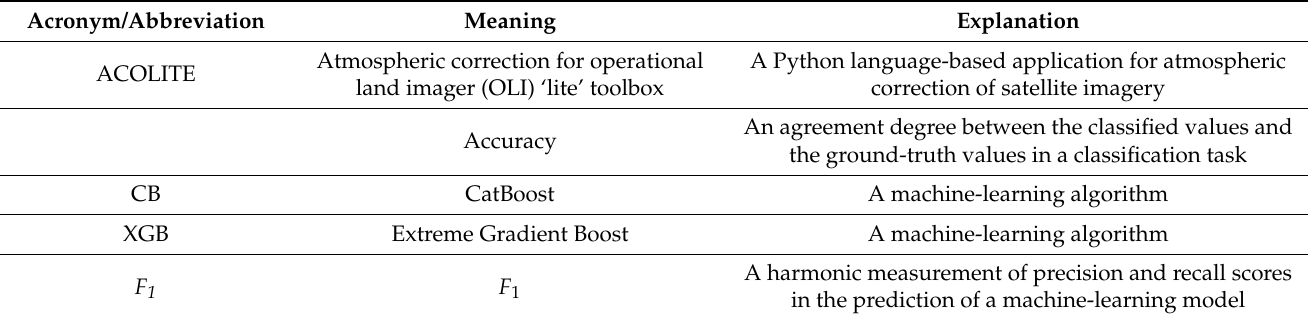
Table A5. List of acronyms and